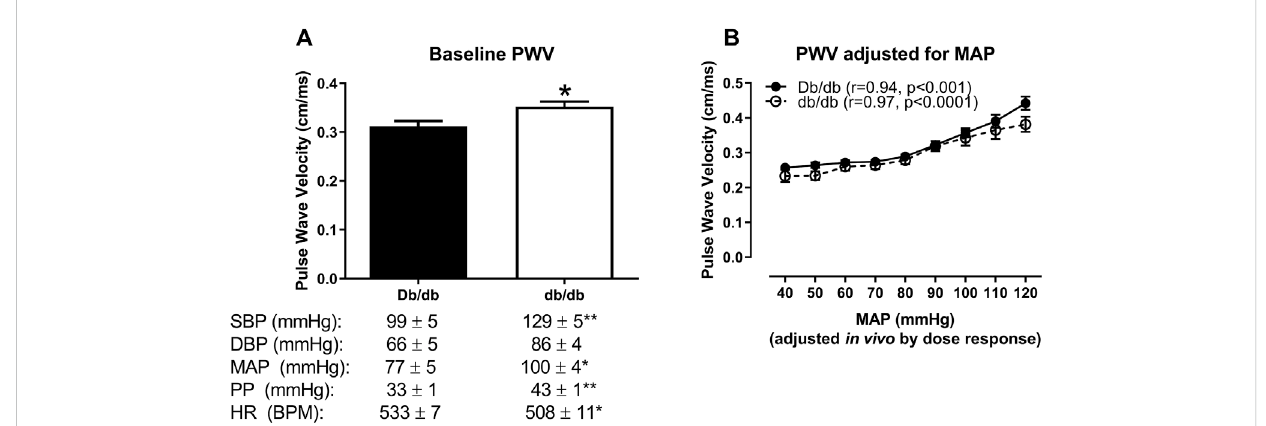
FIGURE 5 In vivo aortic pulse wave velocity measured in anesthetized mice using the gold standard two-catheter method. (A) At baseline (measured prior to the infusion of drugs to modulate blood pressure), aortic PWV was augmented in db/db mice, which was associated with an increase in blood pressure andamodestdecreaseinbloodpressurein16 week-old mice. (B) AorticPWVmeasuredatequivalentmeanarterialpressures(MAPs)inresponsetoan